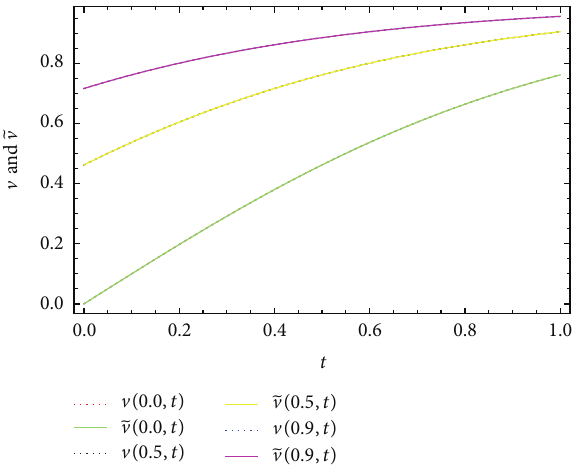
Figure 12: The approximate ̃ V and the exact V solutions for different values of 𝑦 = 0.0 , 0.5, and 0.9 of problem (51), where 𝑁 = 12 and 𝛼 = 𝛽 = −(1/2) in the interval [0, 1]